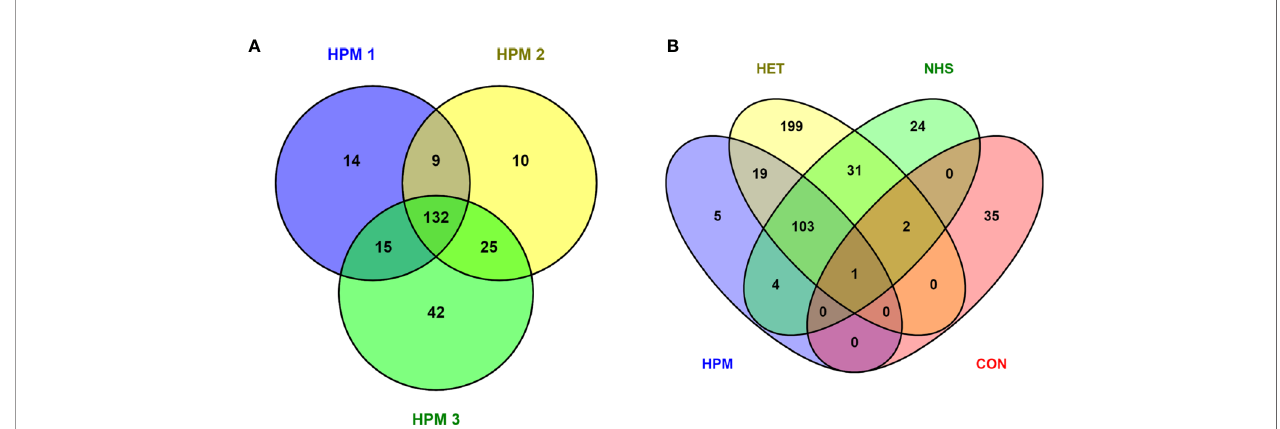
FIGURE 2 | Venn diagrams depicting Histoplasma capsulatum proteins (potential antigens) recognized by the different pooled sera groups. (A) Number of proteins recognized by the pooled sera of patients with histoplasmosis (HPM) for the three biological replicates analyzed (HPM 1, HPM 2, and HPM 3); (B) The 132 proteins in common to all conditions in panel A were compared to the total list of proteins detected in at least one of the biological replicates for the other conditions: HET, pooled sera of patients with other fungal infections or tuberculosis; NHS, pooled sera of normal healthy donors; CON, mock control: phosphate buffered